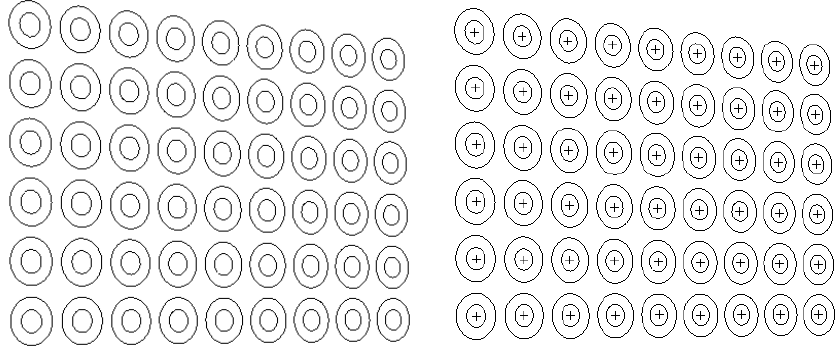
Figure 10. Alignment of the laser plane and the manufactured calibration line.